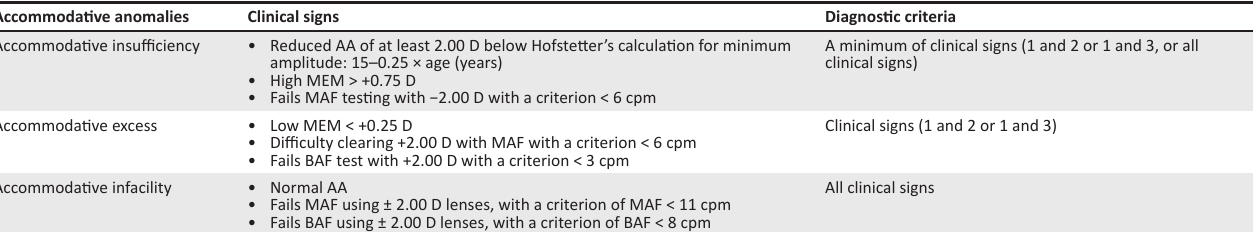
TABLE 2: Classification of accommodative